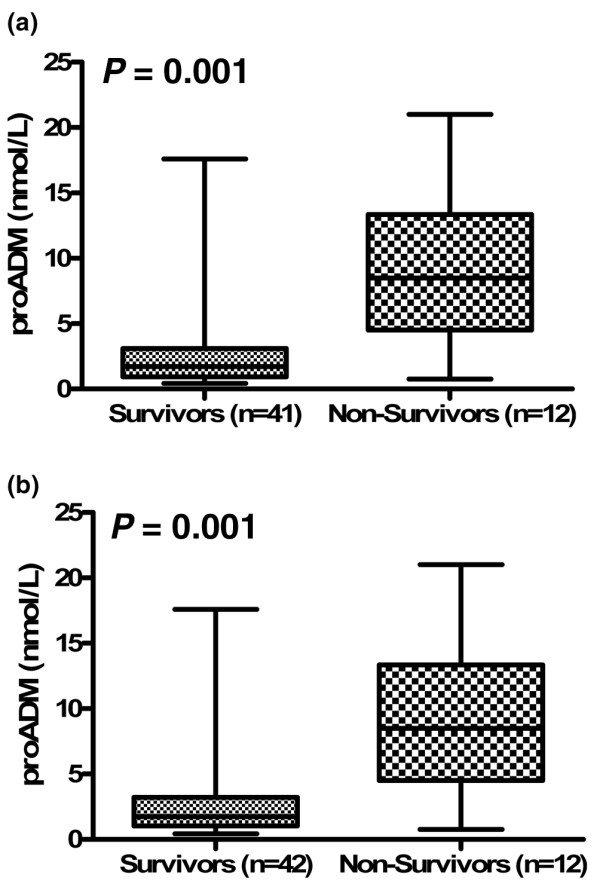
MR-proADM and PCT levels in surviving versus nonsurviving patients. Data from patients on admission are shown. Patients are grouped into (a) those with a clinical diagnosis of sepsis based on international guidelines and (b) those with circulating PCT levels above 1 ng/ml. Lines denote median values, boxes represent 25–75th percentiles and whiskers indicate the range. MR-proADM, mid-regional pro-adrenomedullin; PCT, procalcitonin.